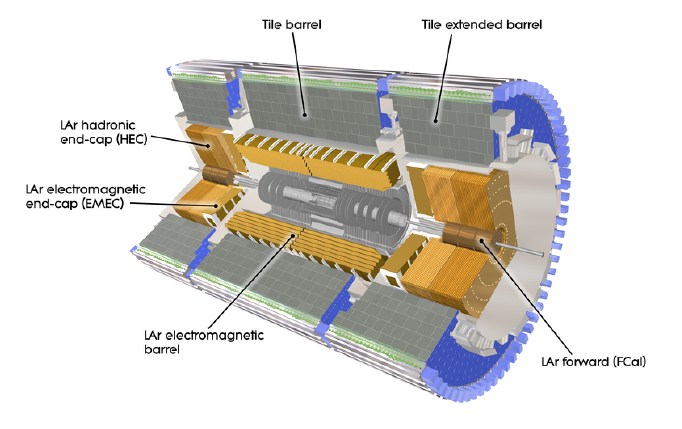
Figure 1. ATLAS detector, the figure shows placement of TileCal within the detector. The TileCal is Figure 2. The ATLAS Tile Calorimeter together with sub-detectors it shown in gray color.